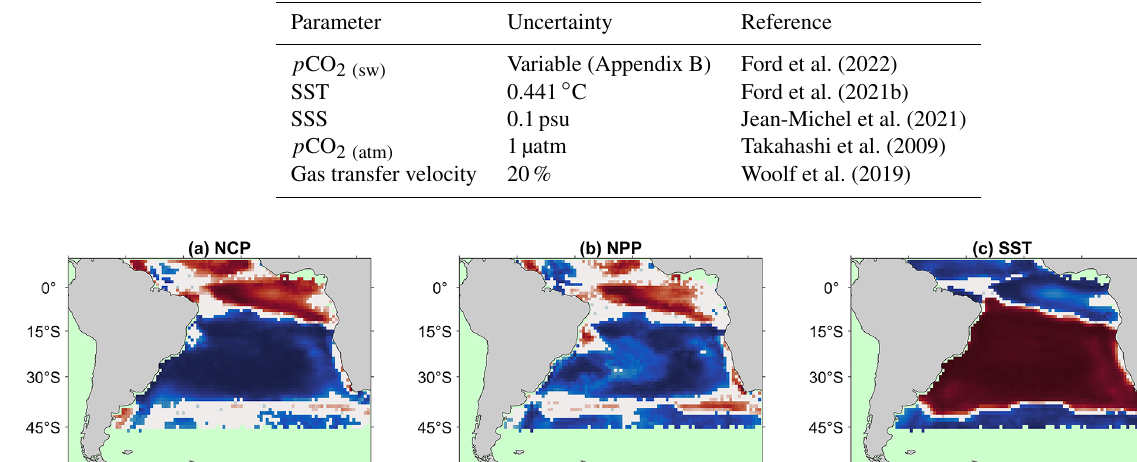
Table 1. Uncertainties in the input parameters used in the Monte Carlo uncertainty propagation.